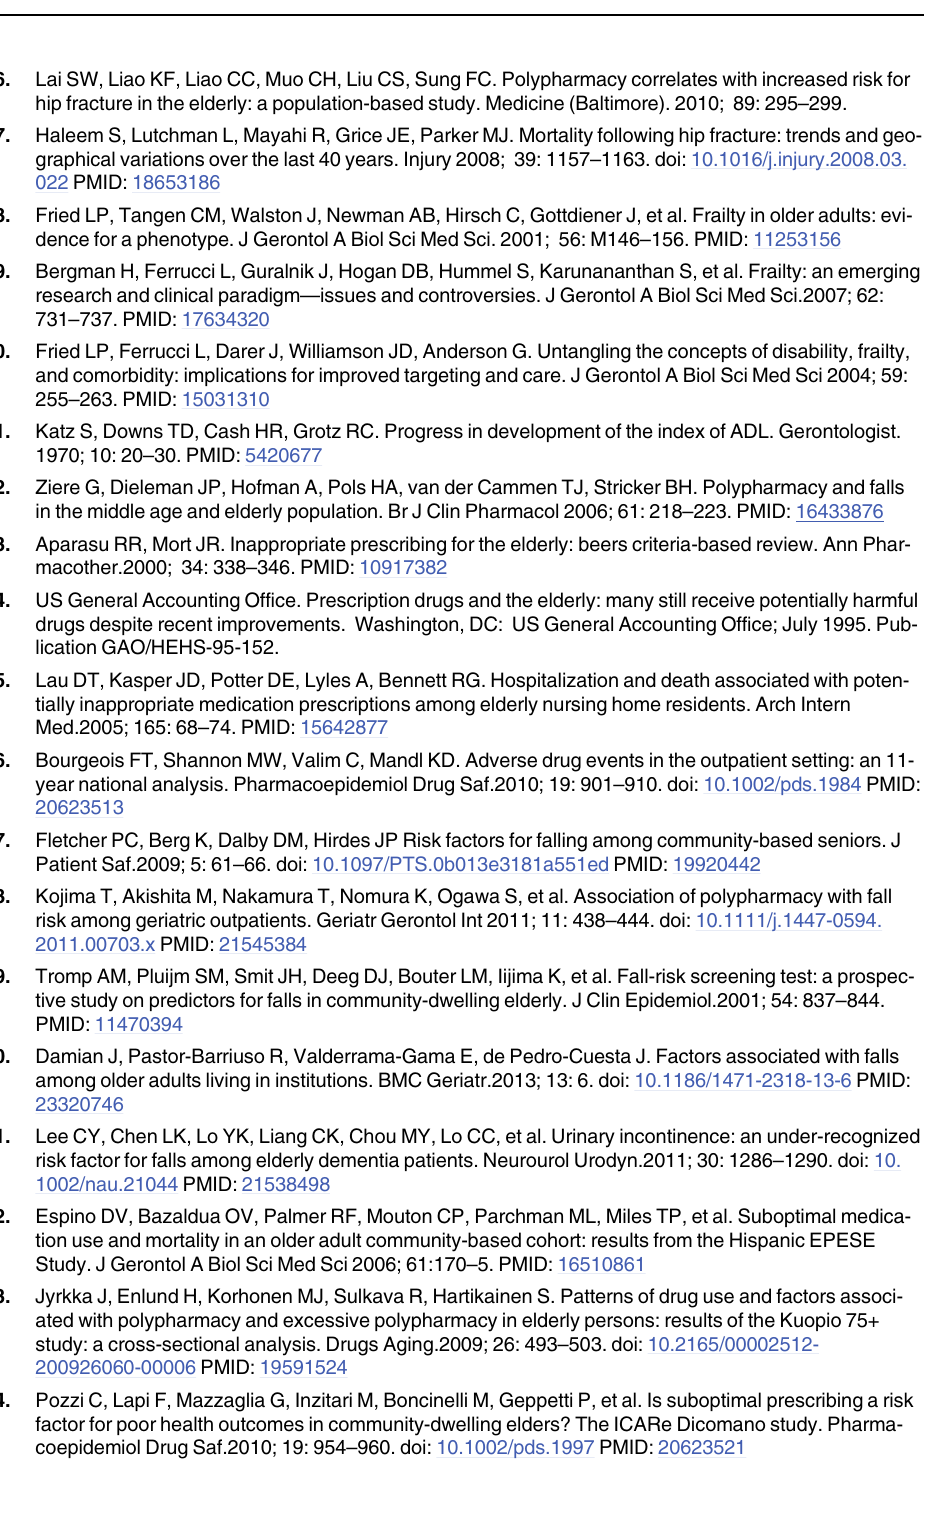
PLOS ONE | DOI:10.1371/journal.pone.0142123 November 10,